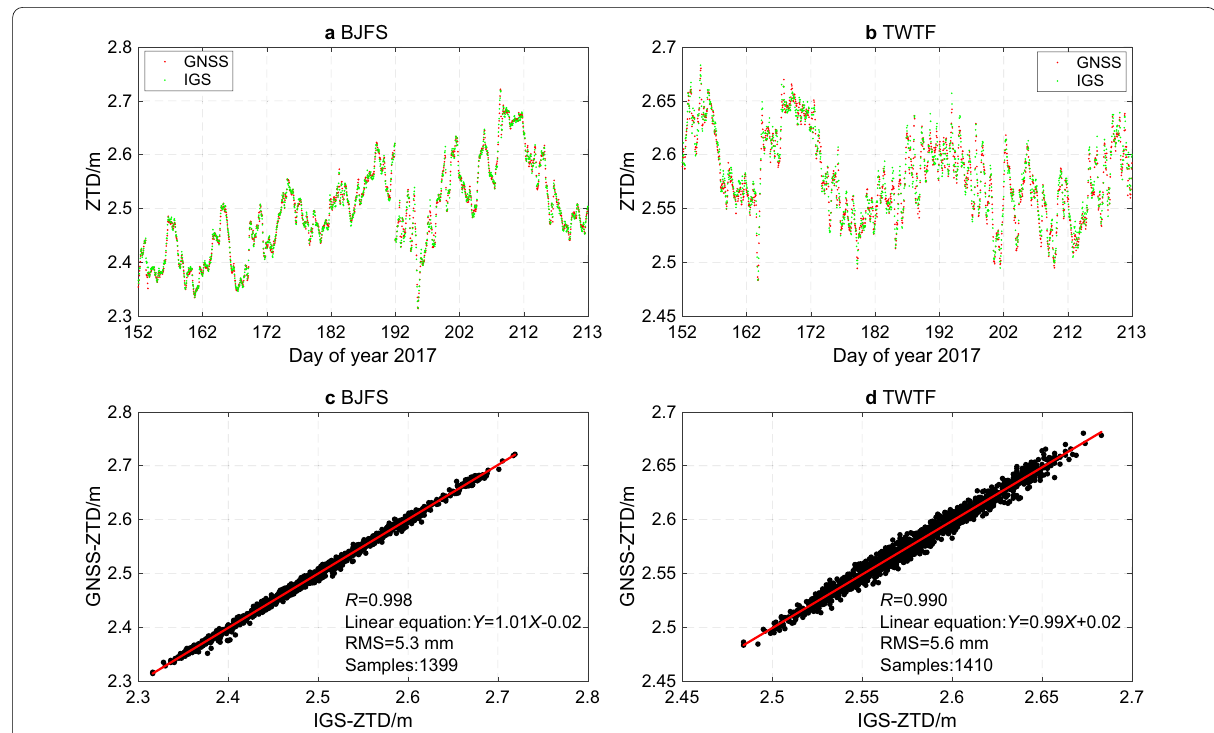
Fig. 2 ZTDs from GNSS observations and IGS center at stations BJFS and TWTF from June to July 2017. a ZTD time series for BJFS and b for TWTF, c correlation plot between IGS-ZTD and GNSS-ZTD for BJFS and d for